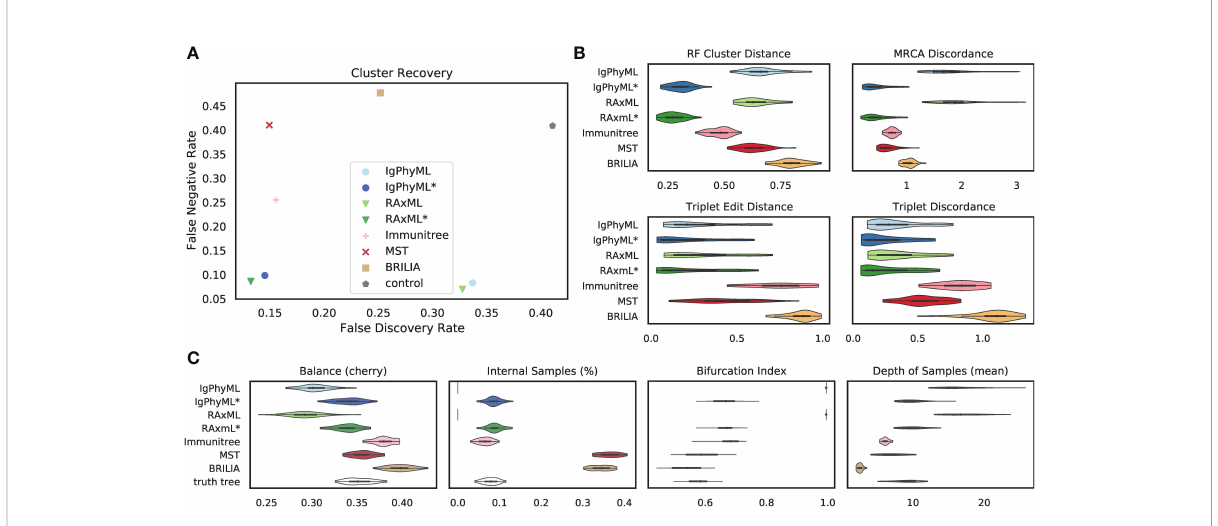
FIGURE 6 (A) False discovery rate (FDR) and false negative rate (FNR), (B) normalized Robinson- Foulds cluster distance (RF), MRCA discordance (MD), triplet edit distance (TED), and triplet discordance (TD) of various reconstruction methods on Flu simulations under default conditions (30 replicates). The “ control ” trees are generated by randomly permuting labels of the true tree. Benchmarking results in (B) are normalized by the control trees. (C) Properties of the estimated and true trees. For results excluding singletons and the PD metric, see Figure S4. *: contracted